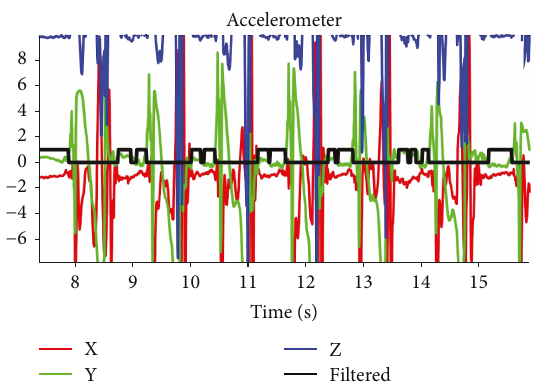
Figure 5: Gait recognition results based on zero-velocity detection.